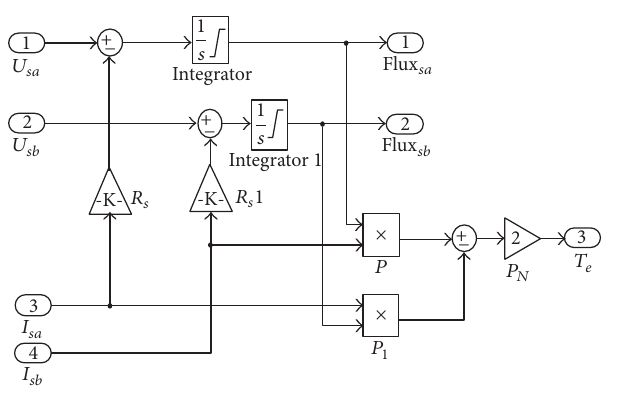
Figure 3: Torque and stator flux observer model.